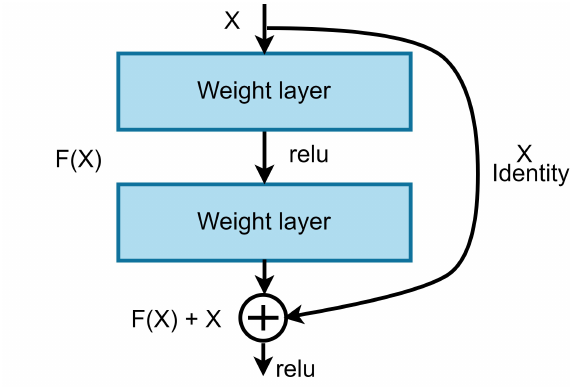
Figure 3. A building block of residual learning from [25].